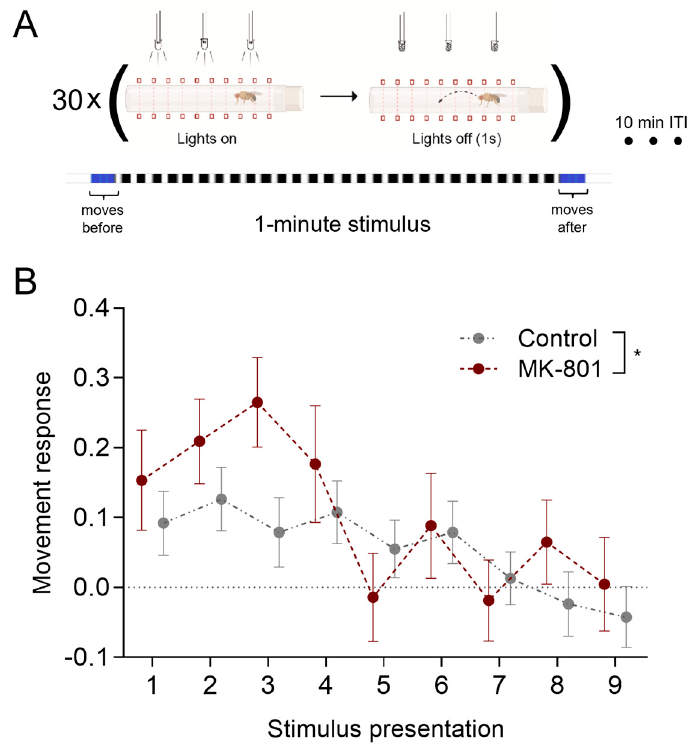
Figure 4. Desensitization to startle-inducing stimuli is affected by MK-801. ( A ). By repeatedly presenting the lights-off stimulus for one minute and by reducing the interval between trials of lights- off stimuli presentation, we tested if the motor response could be inhibited. ( B ). For the first four trials, both groups presented startle responses significantly over baseline and negligible responses afterwards, demonstrating the stimuli desensitization over time (two-way ANOVA, p trial = 0.0006). Nevertheless, MK-801 exposure evoked a distinct movement response ( p MK-801 = 0.043), although no interaction effect was observed ( p interaction = 0.519). Values are shown as mean ± SEM. * p < 0.05.